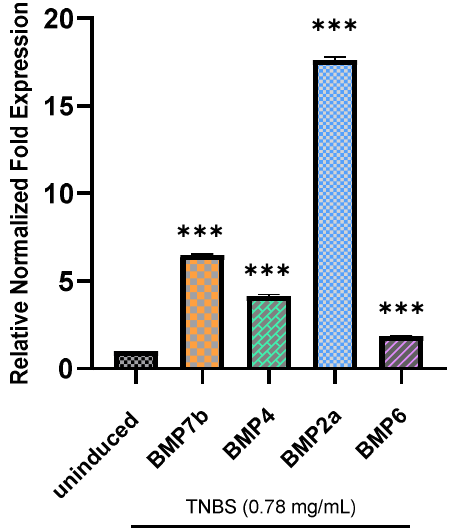
Figure 7. Relative normalized expression of BMP7b , BMP4 , BMP2a , and BMP6 induced with 0.78 mg/mL of TNBS. Thirty 12-day old larvae were pooled from each of the uninduced and TNBS-induced groups for total RNA extraction. All genes were normalized against two reference genes: GAPDH and β actin . Data are expressed as the mean ± S.E.M. of three replicates. Values of *** p < 0.001 were considered significantly different from the uninduced group.